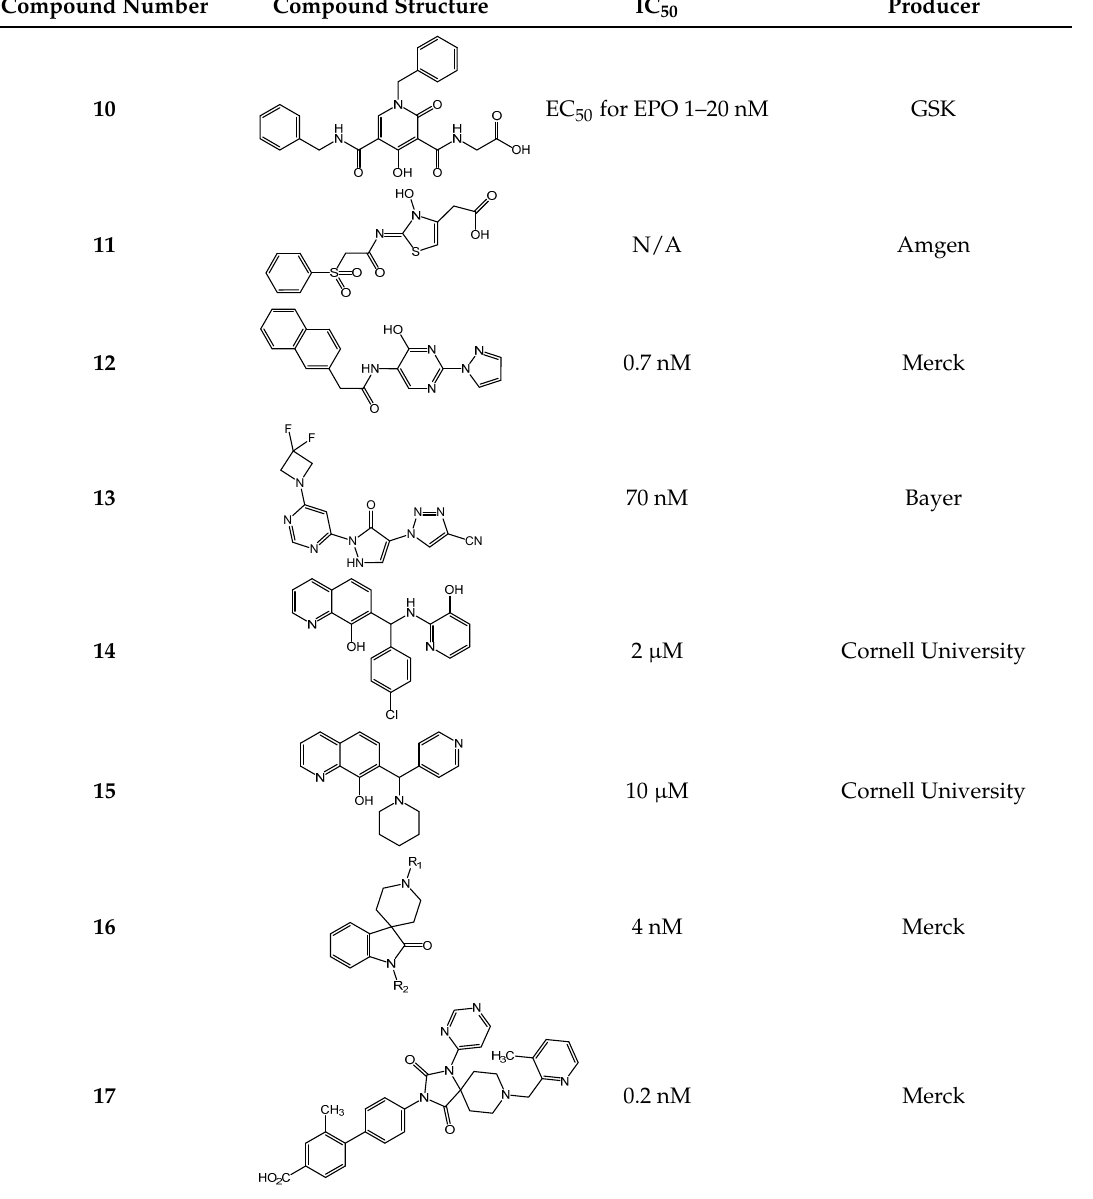
Table 3. PHD inhibitors developed by HTS.